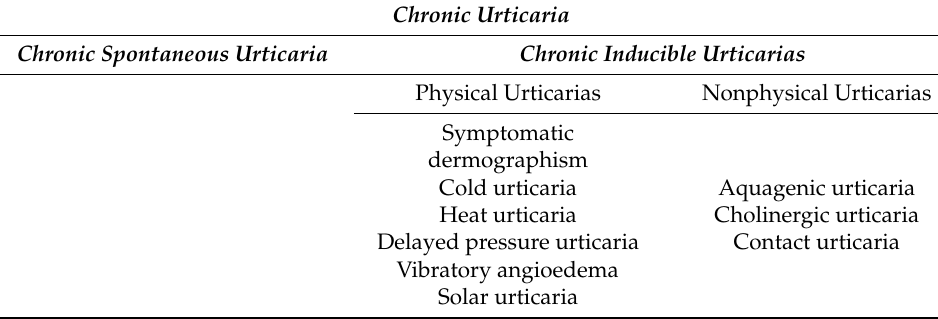
Table 1. Classification of chronic